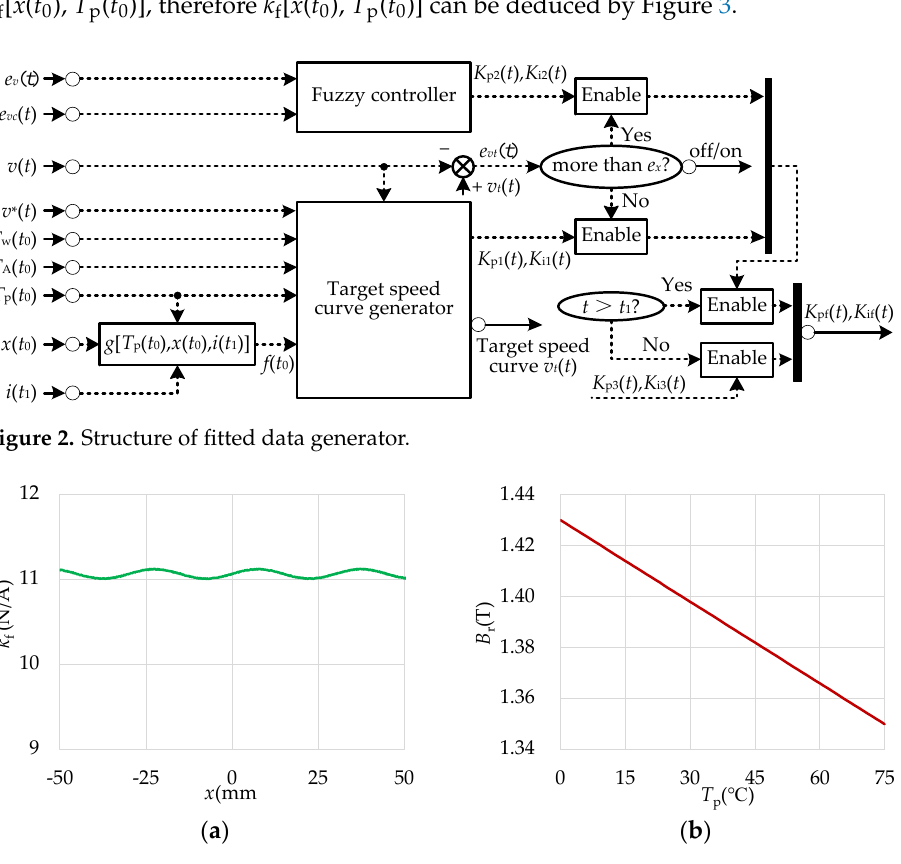
Figure 3. Relevant parameters for thrust constant, ( a ) k f vs. x , ( b ) B r vs. T p . When the whole curve of v *( t ) is detected and v ( t ) ≠ 0 at the first time, the proportional